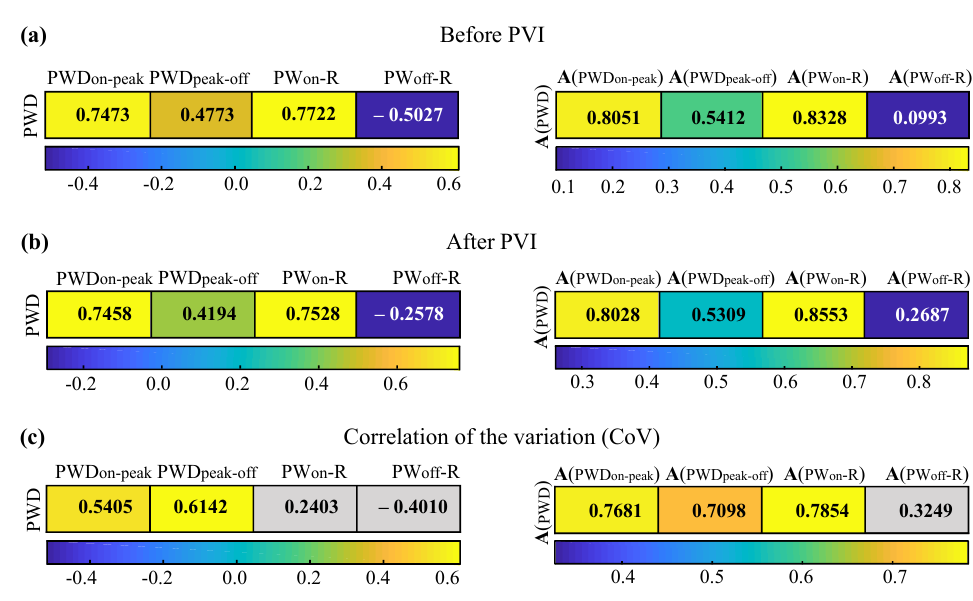
Figure 4. Correlation matrices for the relationship between PWD and the remaining features. Val- ues without scaling are on the left column and with scaling on the right. ( a ) Results before PVI. ( b ) Results after PVI. ( c ) Results for the correlation of the variation. Gray cells show statistically insignificant